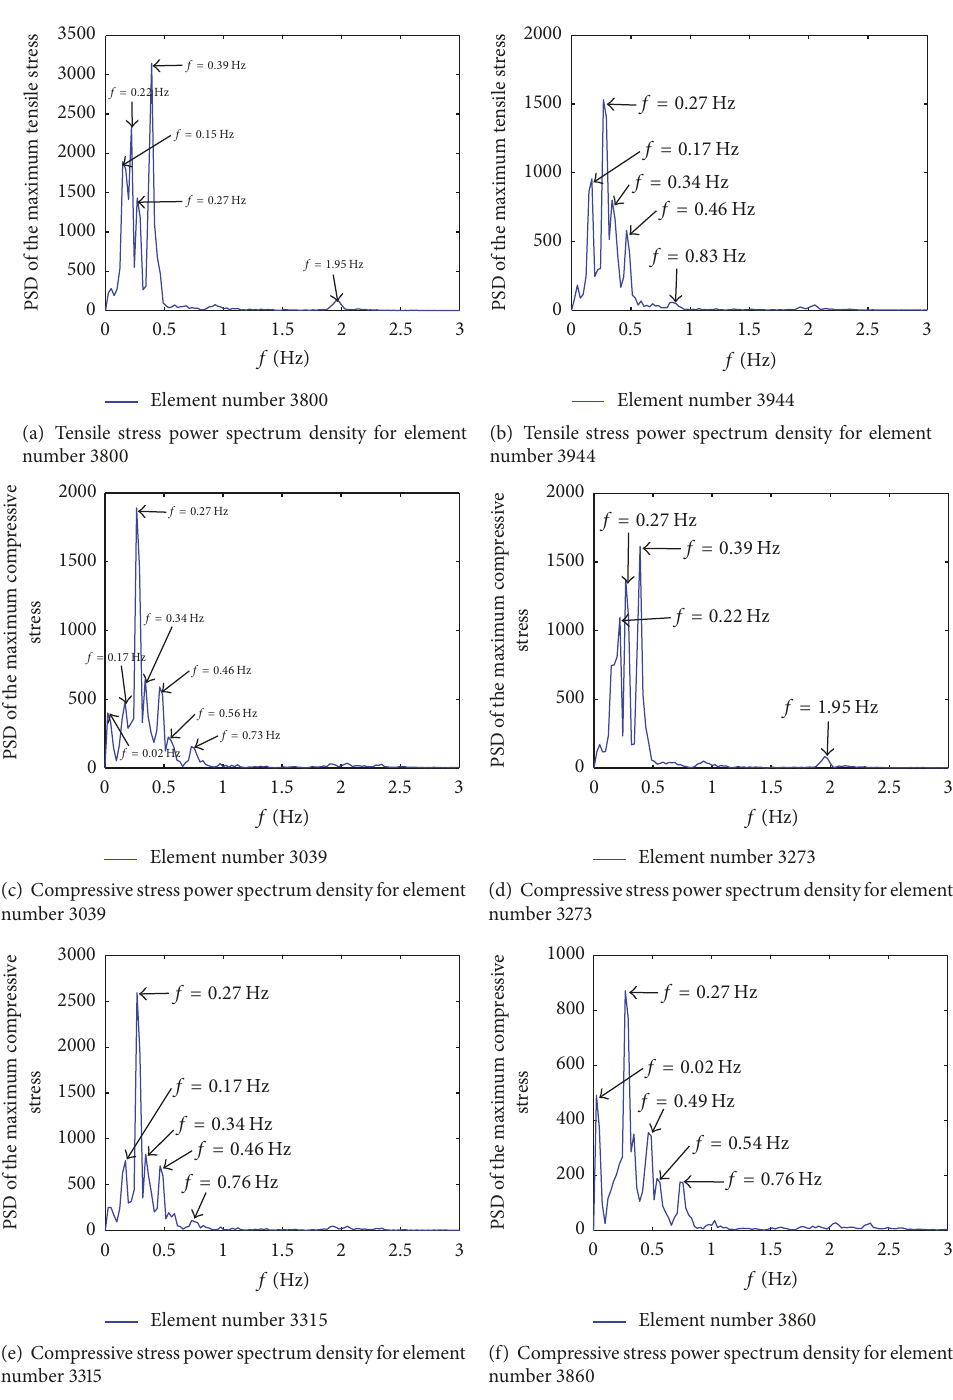
Figure 23: The stress PSD of the main members of the transmission tower in the tower-line system under the design wind speed ( 𝑈 10 = 25.3